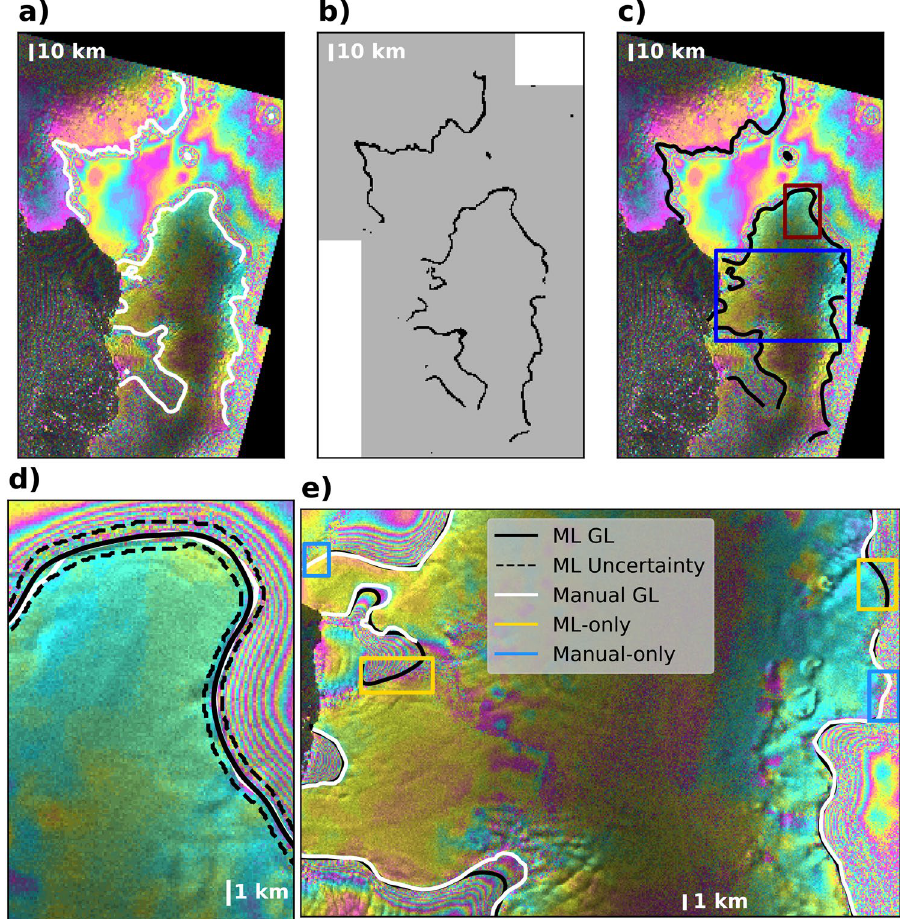
Figure 2. Different steps of the pipeline for ( a ) a sample interferogram with hand-drawn grounding line in white; ( b ) output of the neural network in raster format with a variable width that is a measure of uncertainty of the output. The gray mask in the background represents training (white) and testing (gray) sites; ( c ) Vectorized output and uncertainty contours; ( d ) zoomed-in region highlighted by the maroon box in panel ( c ) showing both manual and ML results and uncertainty bars; ( e ) Comparison of the manual and ML performances in the area outlined in blue in panel ( c ). The interferograms are obtained from Sentinel-1a/b data in 2018 13,14 , and are plotted with Python 3.7.4 17 using Rasterio version 1.0.21 18 and Matplotlib version 3.3.2 19